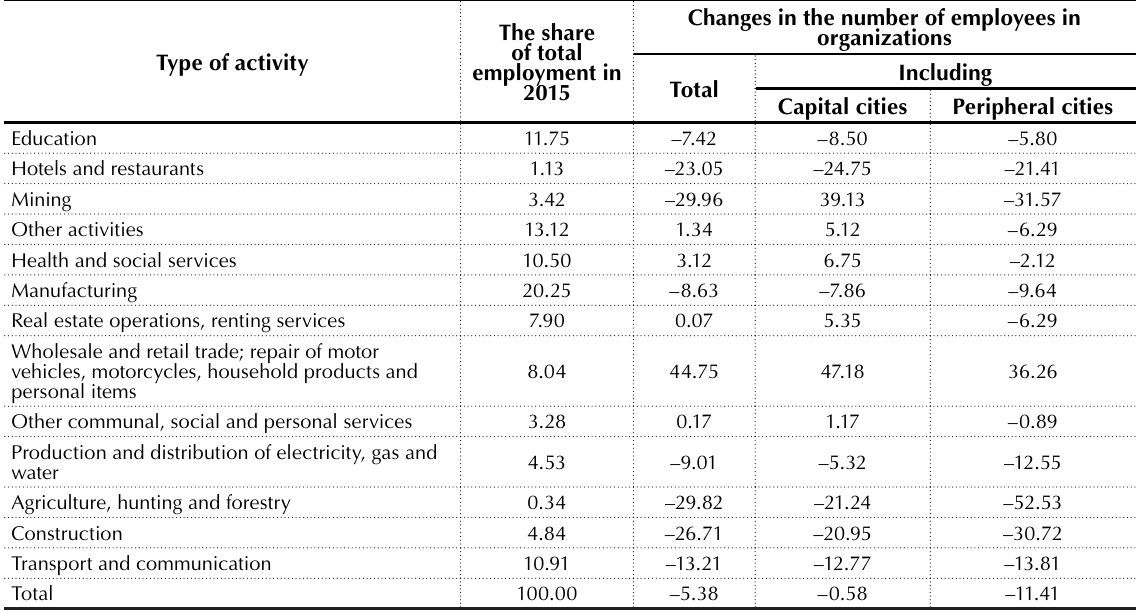
Table 6. Changes in the number of employees in organizations in cities of the Ural Federal District, 2009–2015,